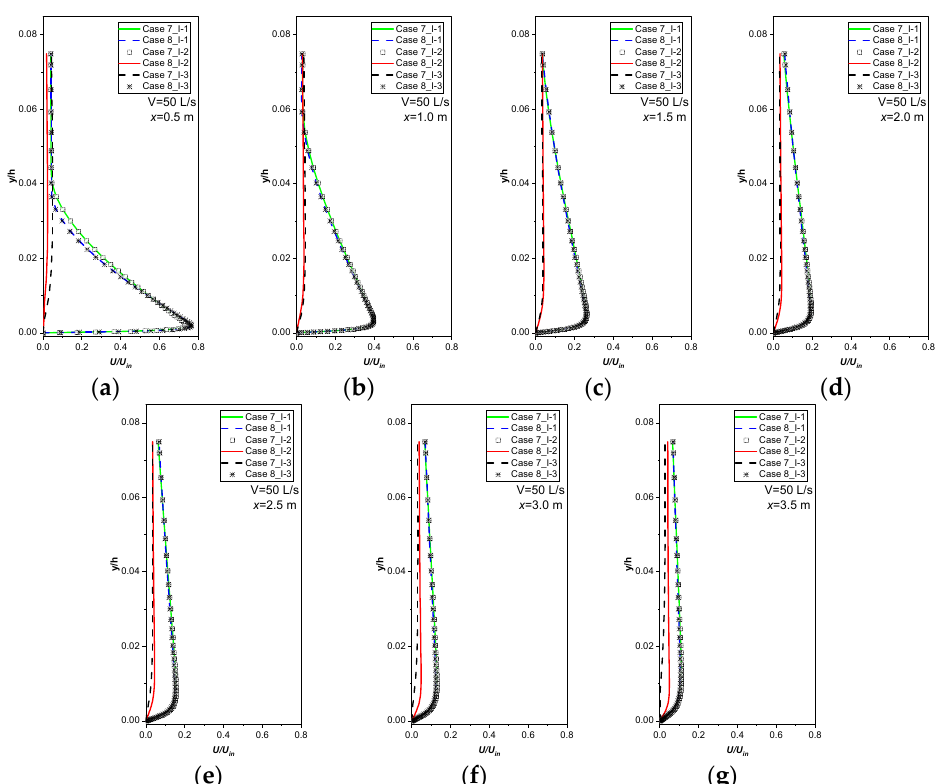
Figure 7. ( a – g ) Show the velocity change along the centerline of the floor for all evaluated cases with V = 50 L/s at x distances 0.5–3.5 m.